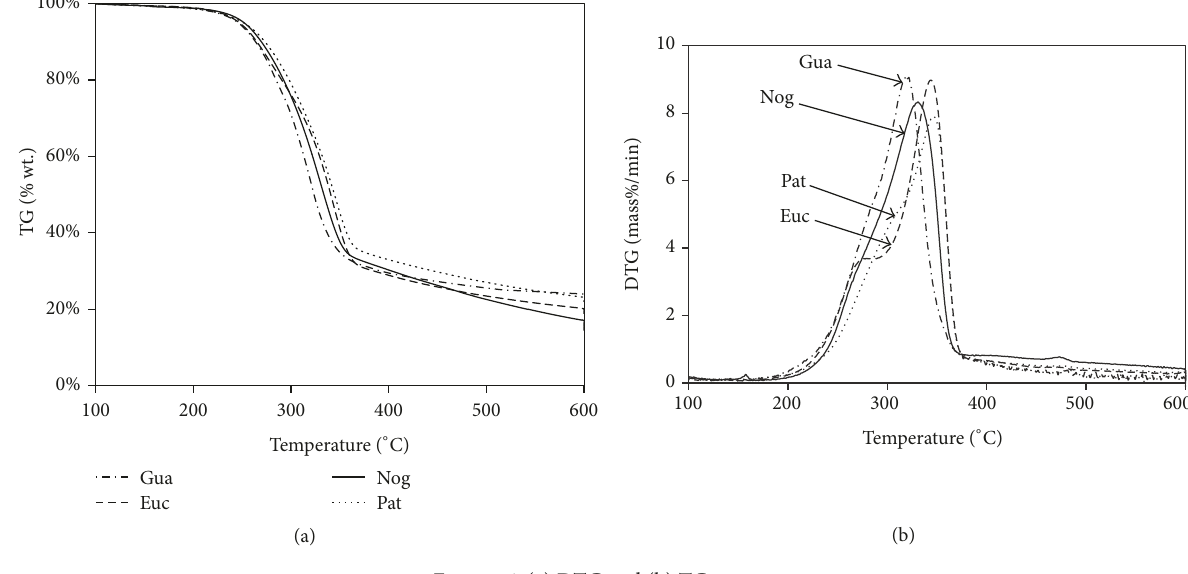
Figure 6: (a) DTG and (b) TG